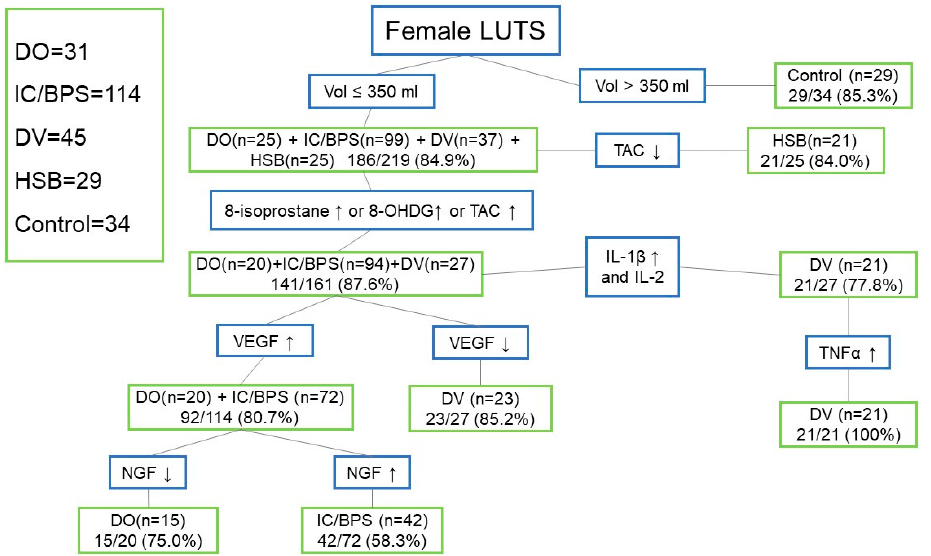
Figure 1. Diagnostic algorithm using urinary biomarkers to identify lower urinary tract dysfunc- tions in women with lower urinary tract symptoms (Abbreviations: LUTS: lower urinary tract symptoms, Vol: volume, DO: detrusor overactivity, IC/BPS: interstitial cystitis/bladder pain syndrome, DV: dysfunctional voiding, HSB: hypersensitive bladder, TAC: total antioxidant capacity, 8-OHdG: 8-hydroxydeoxyguanosine, IL: interleukin, TNF- α : tumor necrosis factor- α , VEGF: vascular endothelial growth factor, NGF: nerve growth factor, BDNF: brain-derived neurotrophic factor, PGE2: prostaglandin E2).